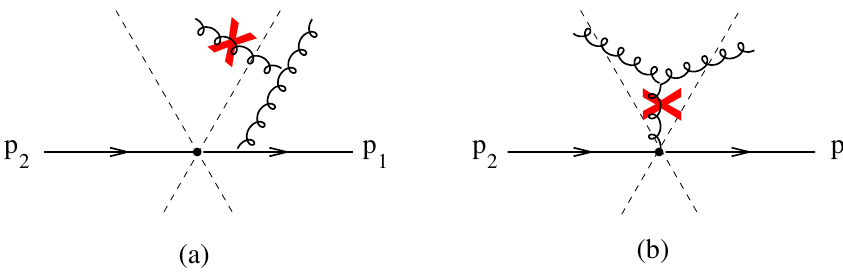
Figure 3 . The two representative contributions corresponding to two soft correlated emissions. The red cross corresponds to the constraint − Θ( v ( k ) − v ) on soft gluon k .